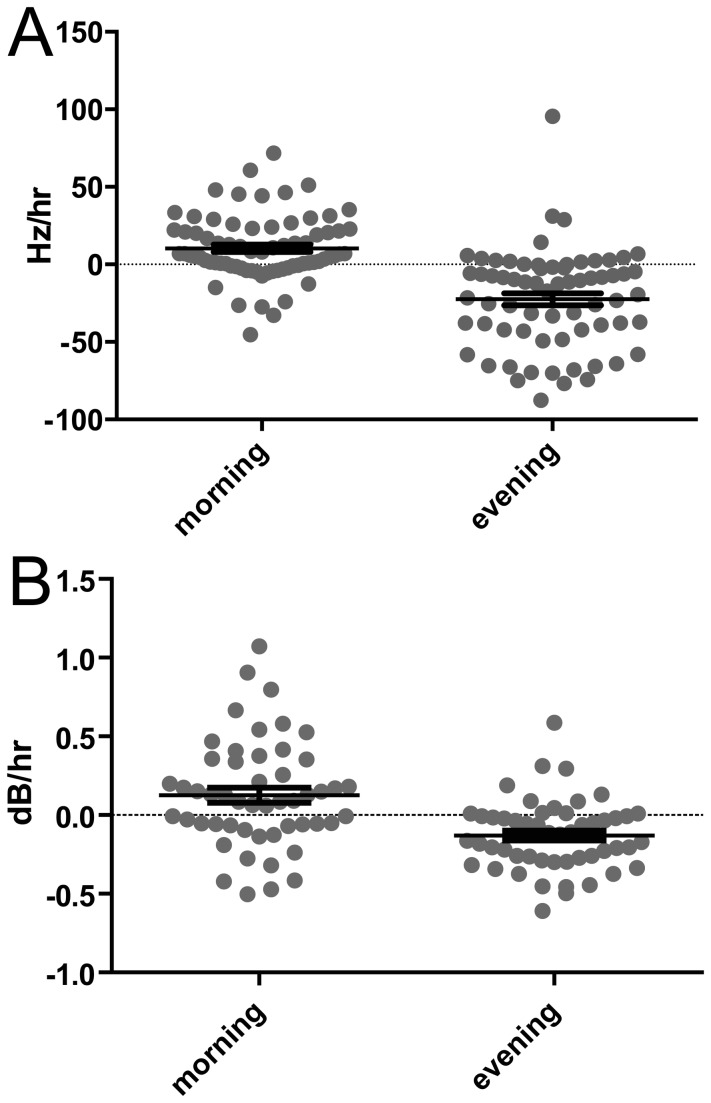
Across animals and across harmonic syllables (and harmonic subsyllabic elements) both FF and amplitude tend to rise in the morning and fall in the evening.Plotted are the slopes of the RLOESS fits for the first three hours of the day and the last three hours of the evening- each point represents the slope of 1 syllable from 1 animal from one morning or evening. Note the apparent ‘v’ shape of the data is an artifact of the algorithm used to make all symbols visible on the graph and does not connote information.